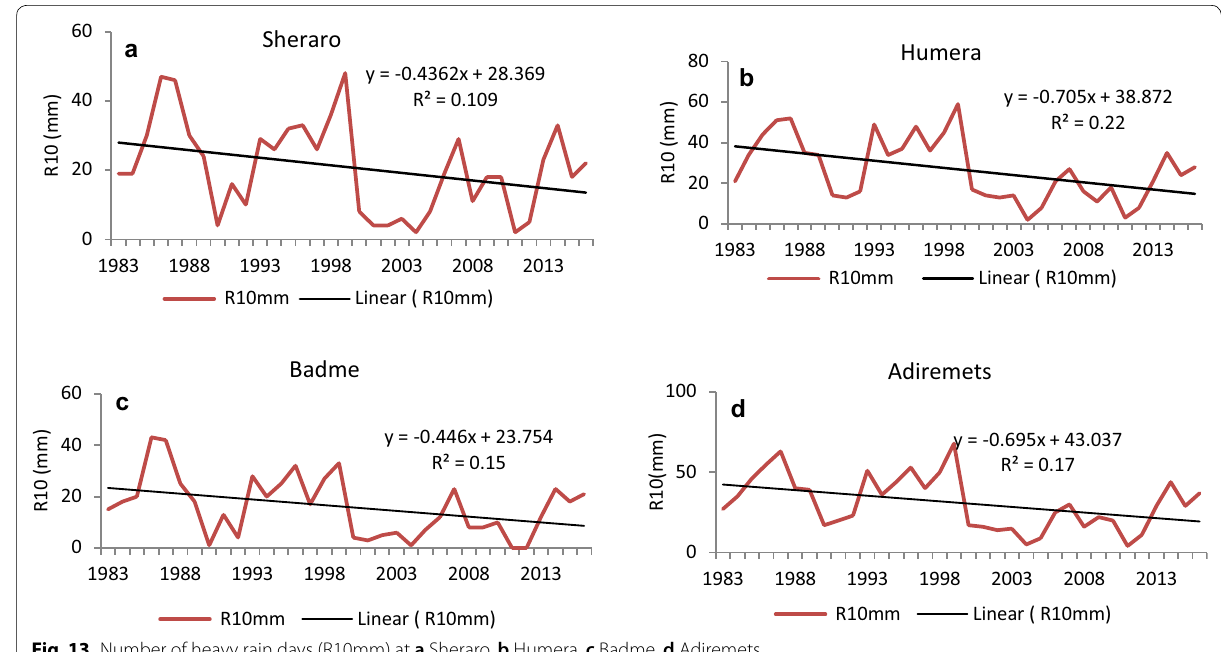
Fig. 13 Number of heavy rain days (R10mm) at a Sheraro, b Humera, c Badme, d Adiremets